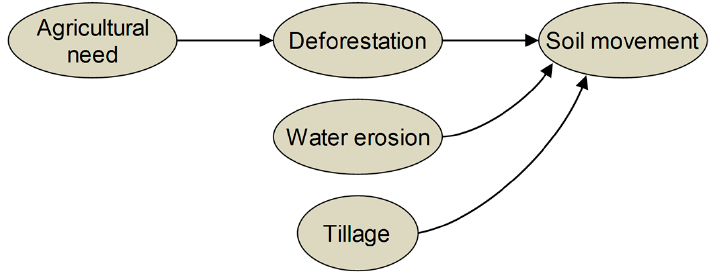
Figure 15. Example of deforestation, the plurality of causes of soil movement.